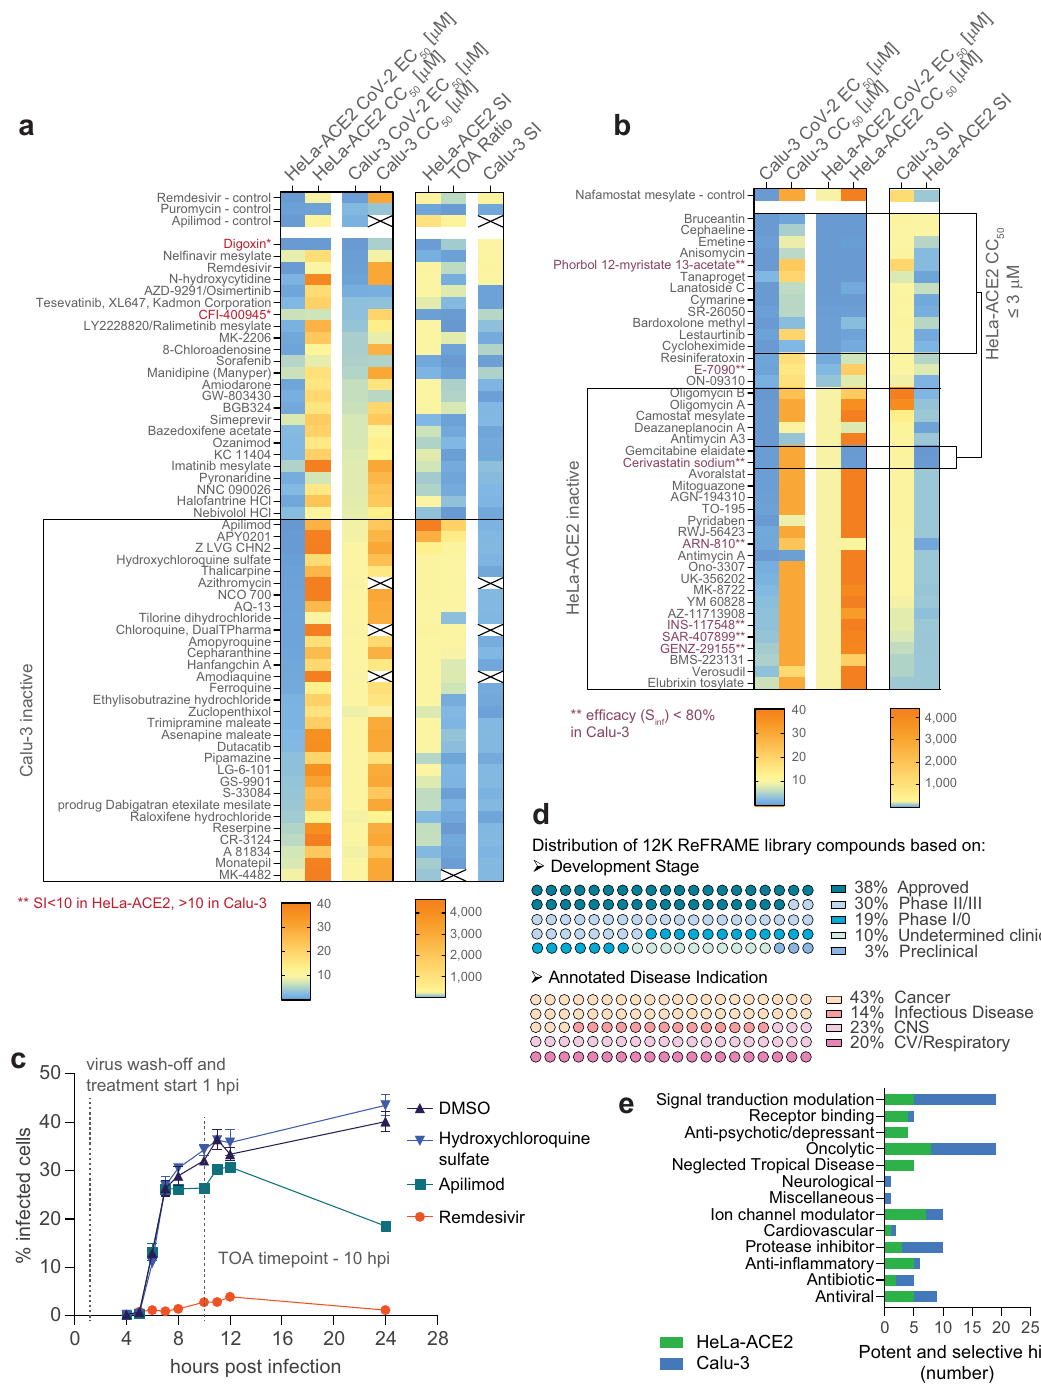
Fig. 2 HeLa-ACE2 and Calu-3 cell-based assays identify largely distinct sets of potent and selective compounds with anti-SARS-CoV-2 activity. a Heat map of activities of HeLa-ACE2 ReFRAME hits recon fi rmed with fresh powder stocks in HeLa-ACE2 and Calu-3 cells (EC 50 , CC 50 , selectivity index (SI)) and the time of addition (TOA) vs standard 24 h assay HeLa-ACE2 antiviral EC 50 ratio. Double asterisk indicates two compounds identi fi ed in primary screening that were not selective in powder recon fi rmation in HeLa-ACE2 cells but were active and selective in Calu-3 cells. X indicates missing data. b Heat map of activities of Calu-3 ReFRAME hits recon fi rmed with fresh powder stocks in Calu-3 and HeLa-ACE2 cells (EC 50 , CC 50 , SI). Double asterisk indicates compounds with antiviral ef fi cacy in Calu-3 < 80%. All raw data from experiments graphically represented in a and b are reported as part of Supplementary Data 1 and 2 and include the independent number each measurement was performed ( ≥ 3 for most compounds/assays). c HeLa-ACE2 TOA time course showing SARS-CoV-2 % infected cells at different times post-infection. Cells were infected with virus for one hour, washed extensively prior to compound treatment, and fi xed at the indicates times. The 10 hpi timepoint was chosen for the TOA assay. Means± s.d. are shown, n = 3 technical replicates examined over one independent experiment. d The composition of the ReFRAME repurposing library with respect to clinical stage of development and disease indication. e Classi fi cation of HeLa-ACE2 and Calu-3 potent and selective hits according to their functional annotation. Source data are provided as a Source Data fi